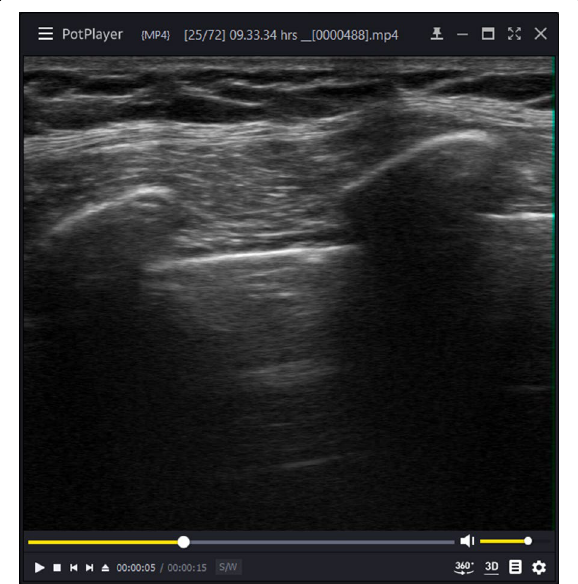
Fig. 4 A cropped 15-s clip played in a random order to the